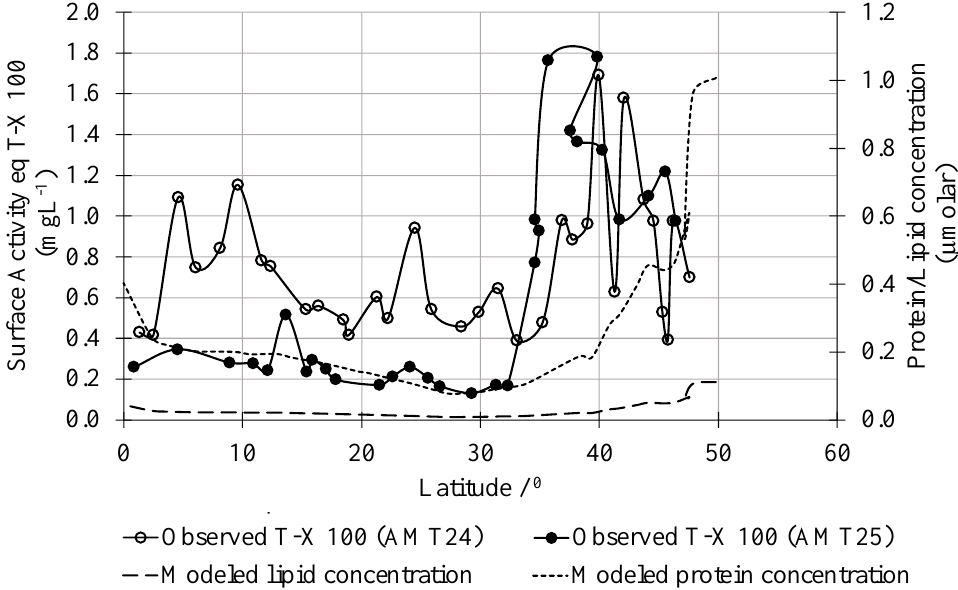
Figure 6. Comparison of observed North Atlantic surface activity measured as T-X-100 concentration and estimated surface activity (surface adsorption concentration) as determined by modeled protein and lipid concentrations.